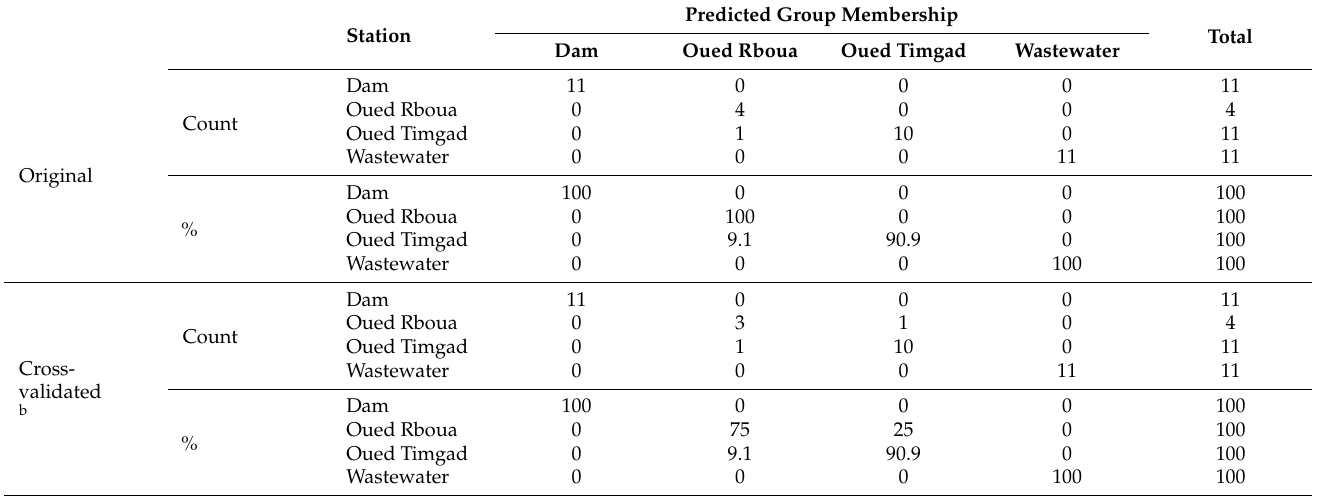
Table 14. Classification results a,c